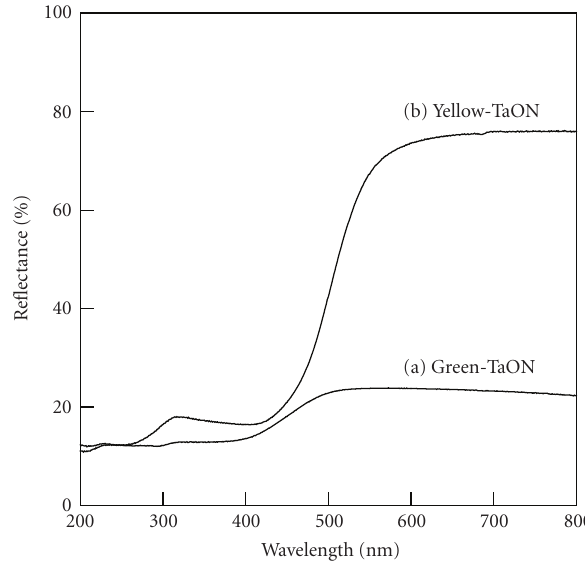
Figure 2: Di ff use reflectance spectra of TaON synthesized via liquid-NH 3 process: (a) green TaON and (b) yellow TaON.